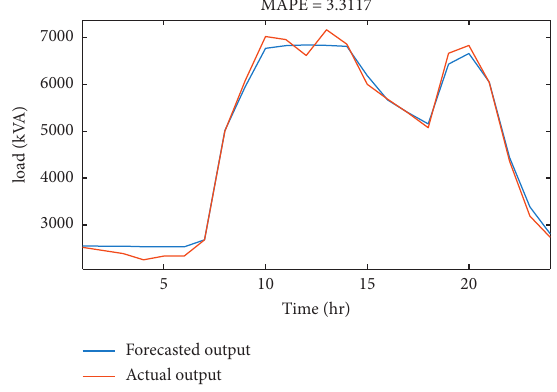
Figure 25: The Fuzzy-PSO prediction of weekend day load.